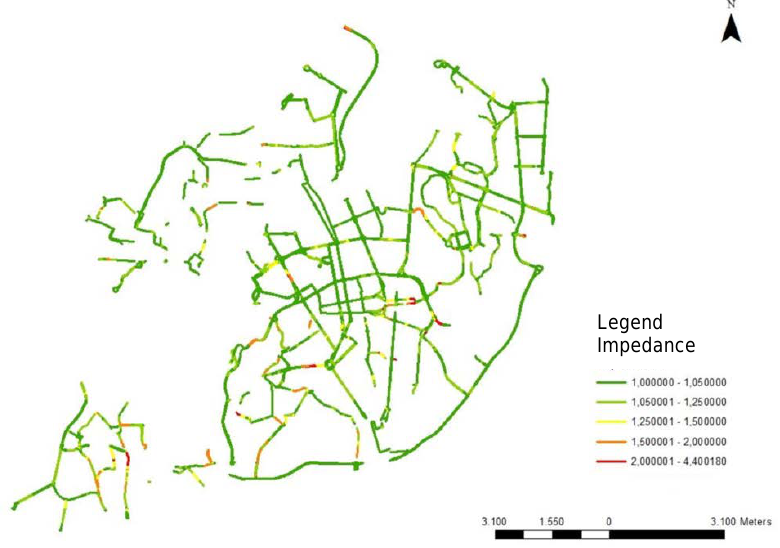
Figure 8. Impedance of the cycle network obtained with criteria 1 plus parking